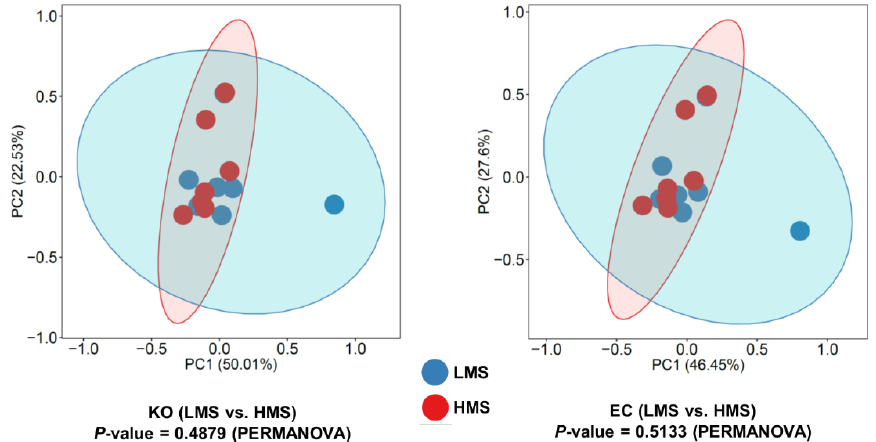
Figure 4. Principal components analysis of PICRUSt2 functional prediction retrieved from prokaryotic populations in the rumens of Korean beef cattle. PERMANOVA was computed for non-parametric statistical tests between low marbling score (LMS) and high marbling score (HMS) groups. Animals 2020 , 10 , x